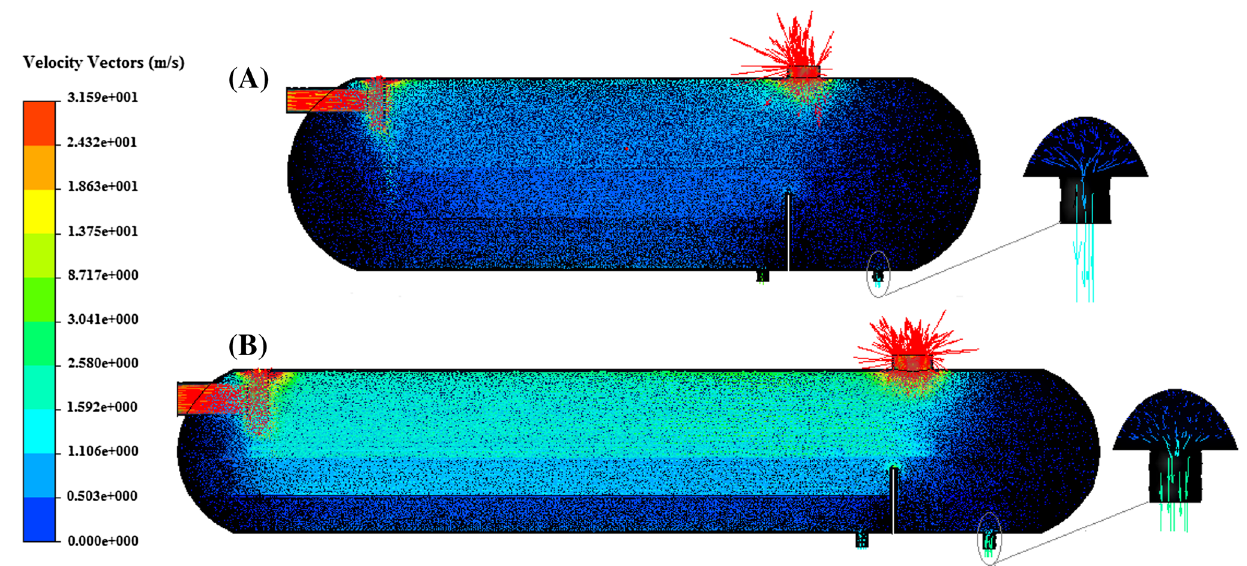
Fig. 16 Simulated velocity vectors (m/s) of Cases 3 ( a ) and 5 ( b